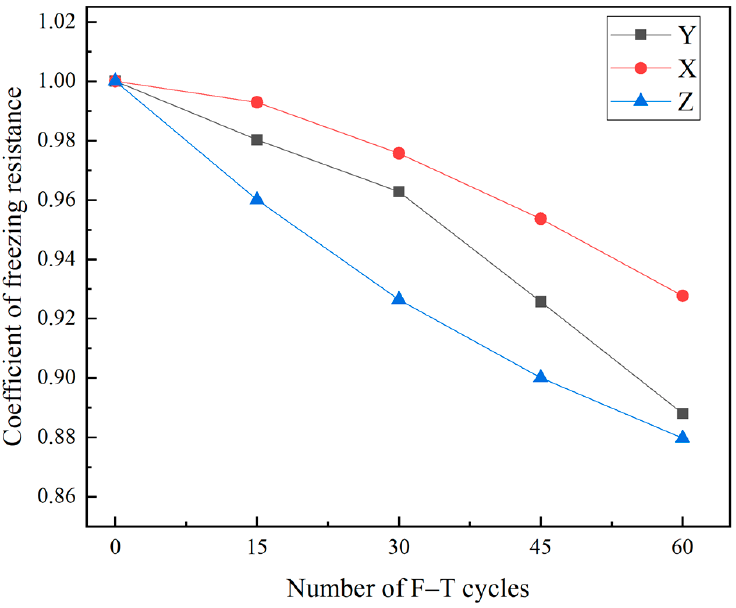
Figure 6. Compressive strength curve of three freeze–thaw cycle treatments.